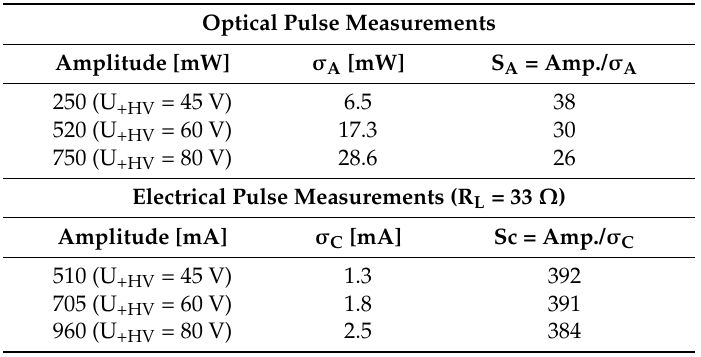
Figure 11. Pulsed optical signal peak amplitude stability measured for t FWHM = 900 ps, f rep = 1 MHz and peak power of: ( a ) 250 mW, σ A = 6.5 mW; ( b ) 520 mW, σ A = 17.3 mW; ( c ) 750 mW, σ A = 28.6 mW. Table 3. Pulse-to-pulse amplitude stability (t FWHM = 900 ps, f rep = 1